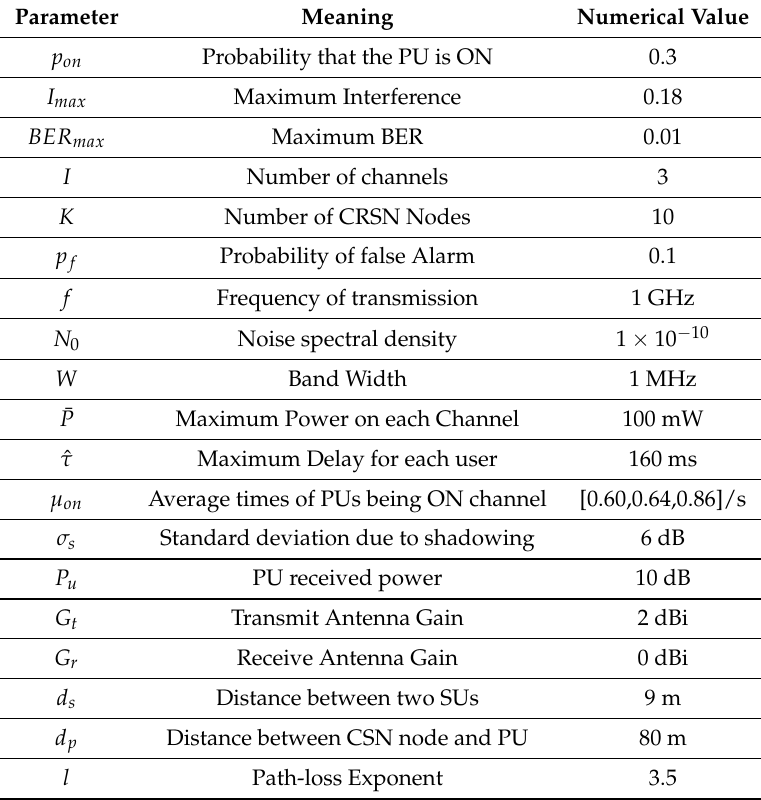
Table 1. Parameter values used in the